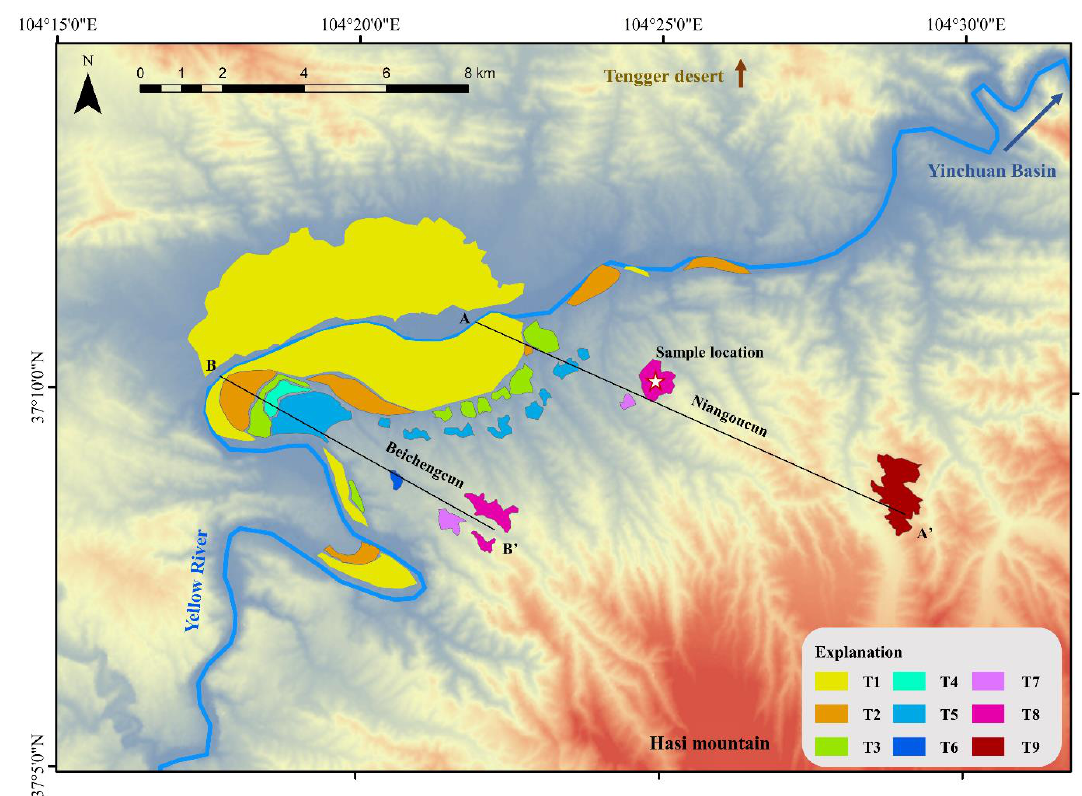
Figure 3. Topographic map (SRTM V4 90 m) with the distribution of the Yellow River terraces in the Wufo Basin (see location in Figure 1). Note: the single terrace 9 (not studied in this paper) is far away from the Yellow River with subangular to subrounded gravels (see Figure 5g), and thus it was possibly formed by local rivers. The lines (A-A’ and B-B’) locate the longitudinal geomorphic section in Figures 4 and 6, respectively.